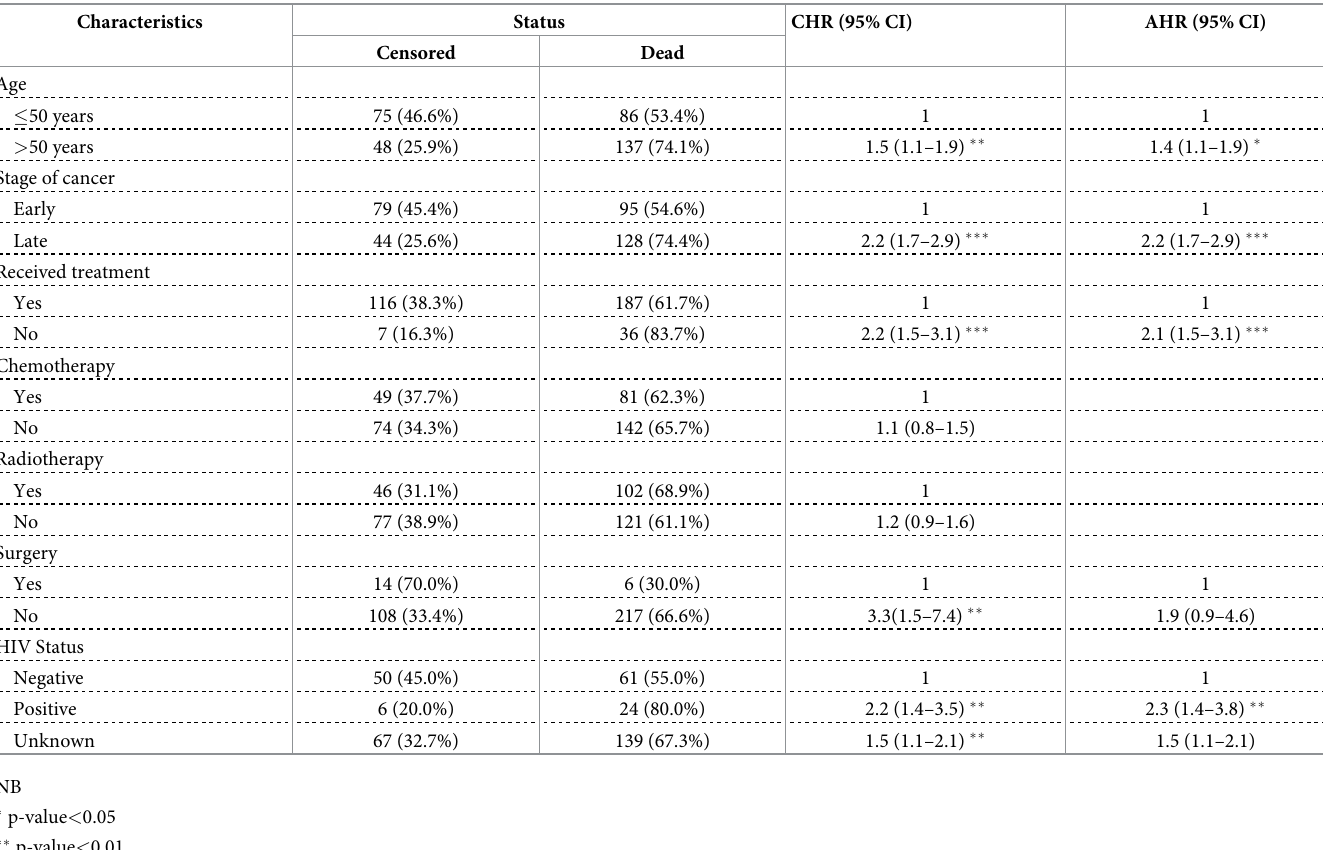
Table 5. Cox regression analysis of predictors of time to death among CCP in TASH, 2014–2019.